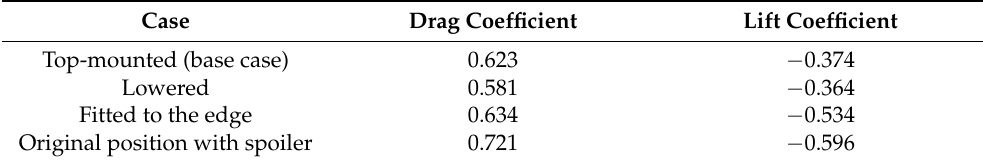
Figure 5. Contours of pressure coefficient on the car’s body with superimposed pathlines: ( a ) Top- mounted (base case); ( b ) lowered; ( c ) fitted to the edge; ( d ) original position with spoiler. Table 2. Aerodynamic coefficients for the rear wing in the braking